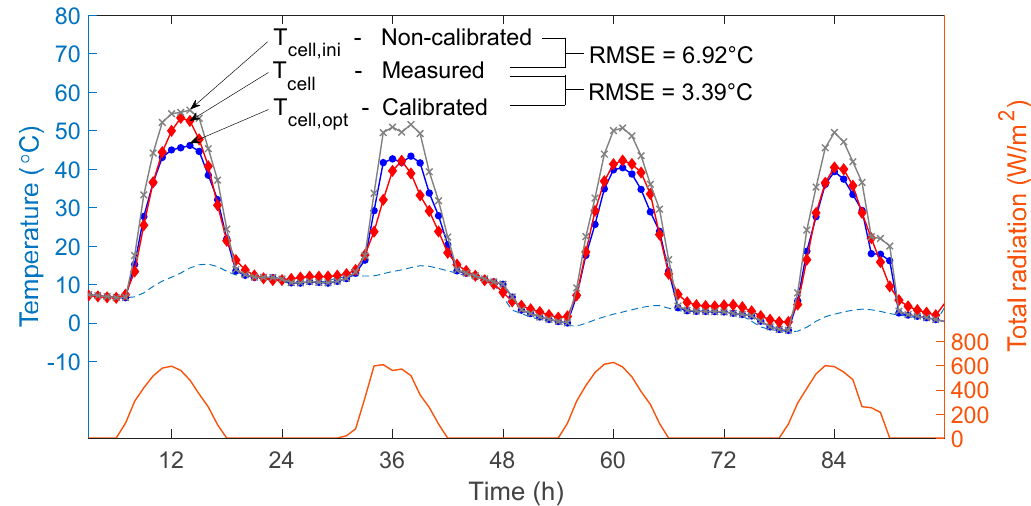
Figure 8. Results of calibrated and noncalibrated models for BIPV cell temperatures (first four days).